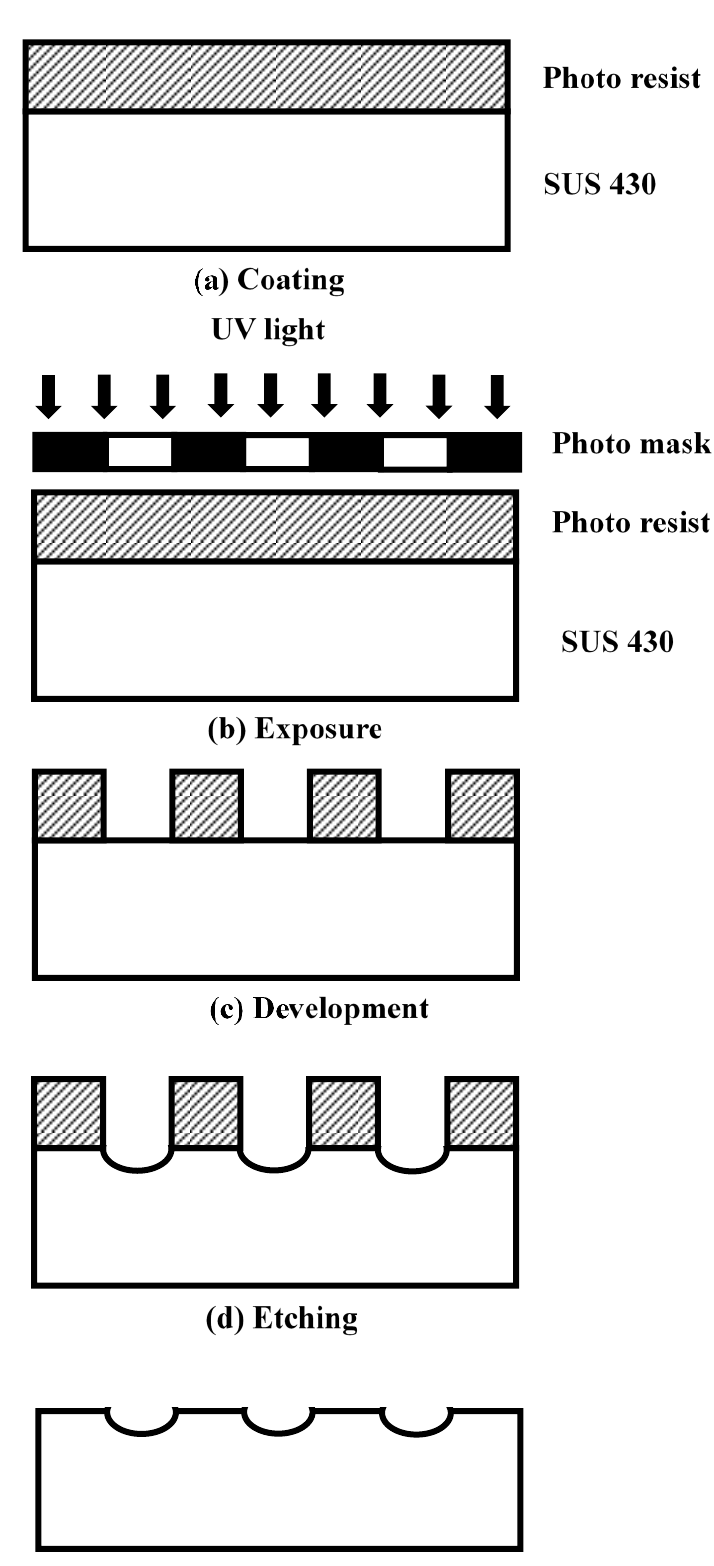
Figure 2. Process chart for photo-etching of mold insert.